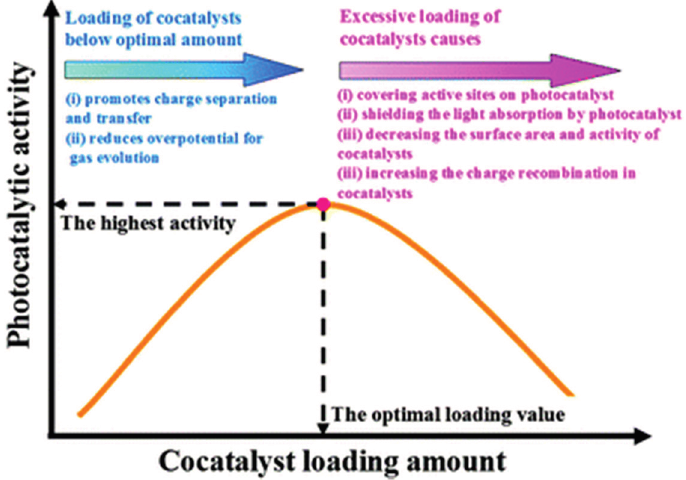
Figure 15. Principle of optimum loading of cocatalyst on a visible-absorbing semiconductor photocatalyst (reproduced from [209] with permission of the Royal Society of